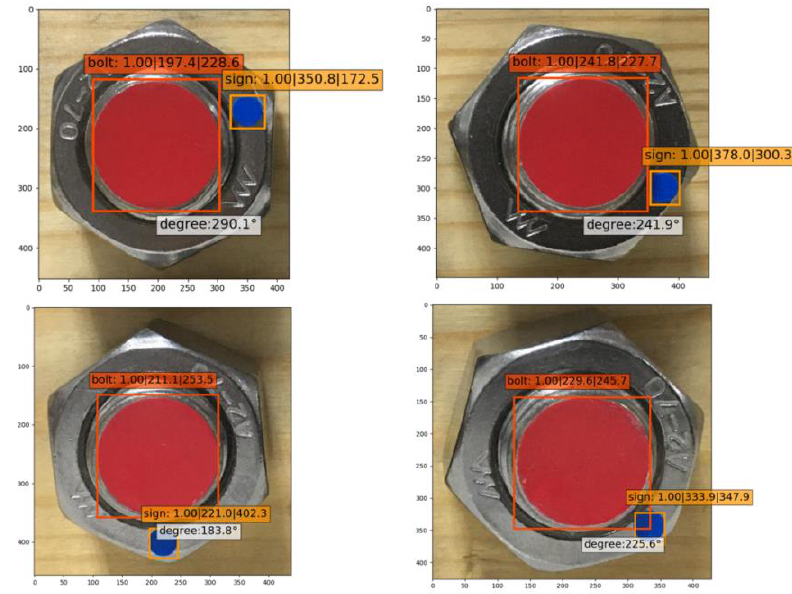
Figure 18. Secondary identification results of a multi-bolted connection.